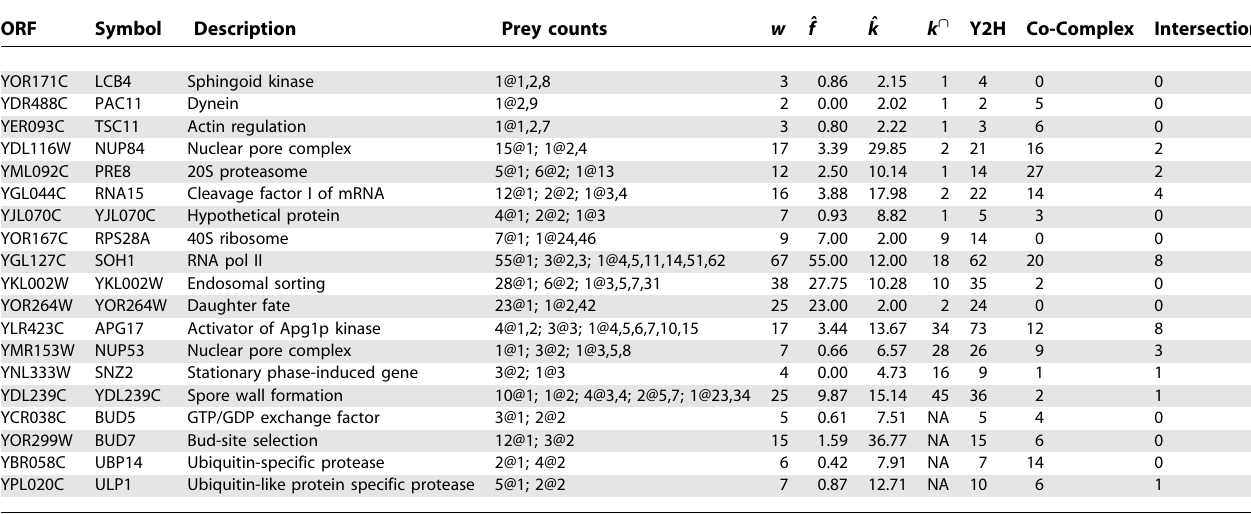
Table 9. Protein Interaction Count Predictions Provided from This Method, ˆk , and from a Previous Method, k ˙